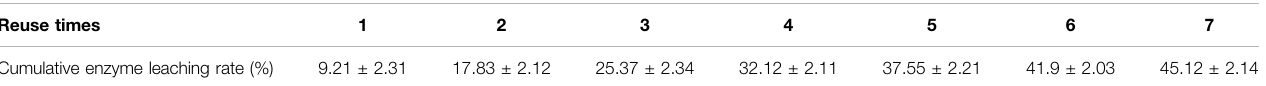
TABLE 3 | The cumulative enzyme activity loss rate of Mb/SBA-15. Reuse times 1 Cumulative enzyme leaching rate